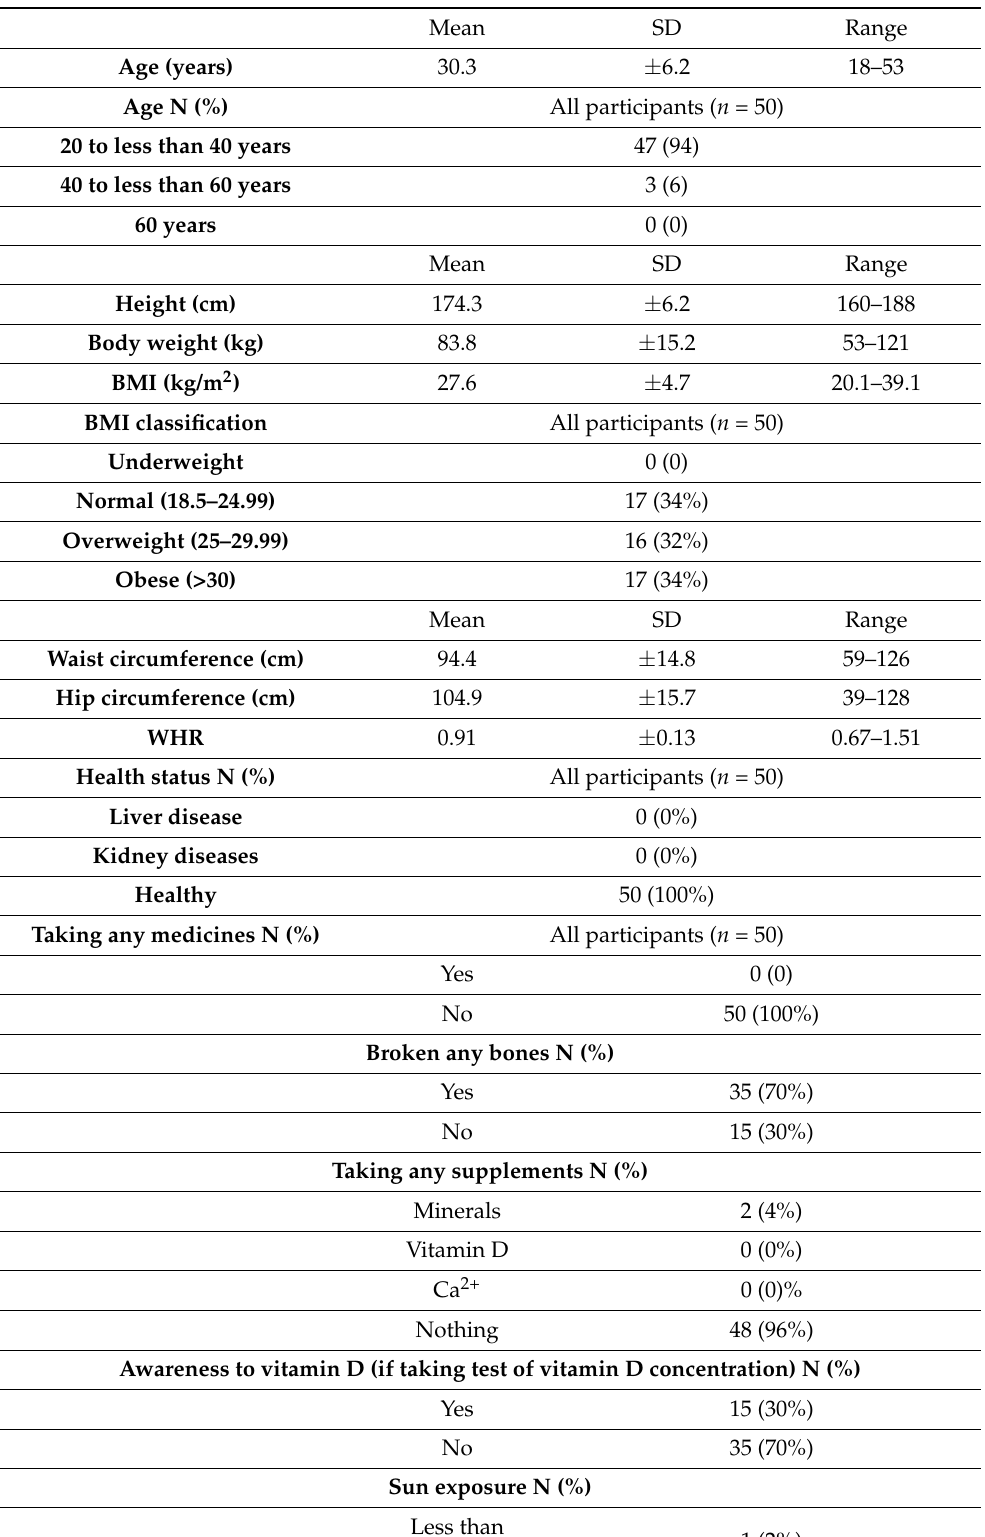
Table 1. Demographic characteristics of studied participants. SD, standard